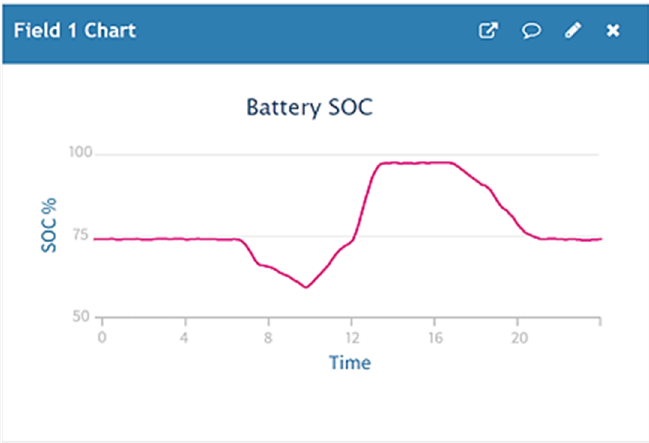
Figure 13. Web server visualization of battery status.